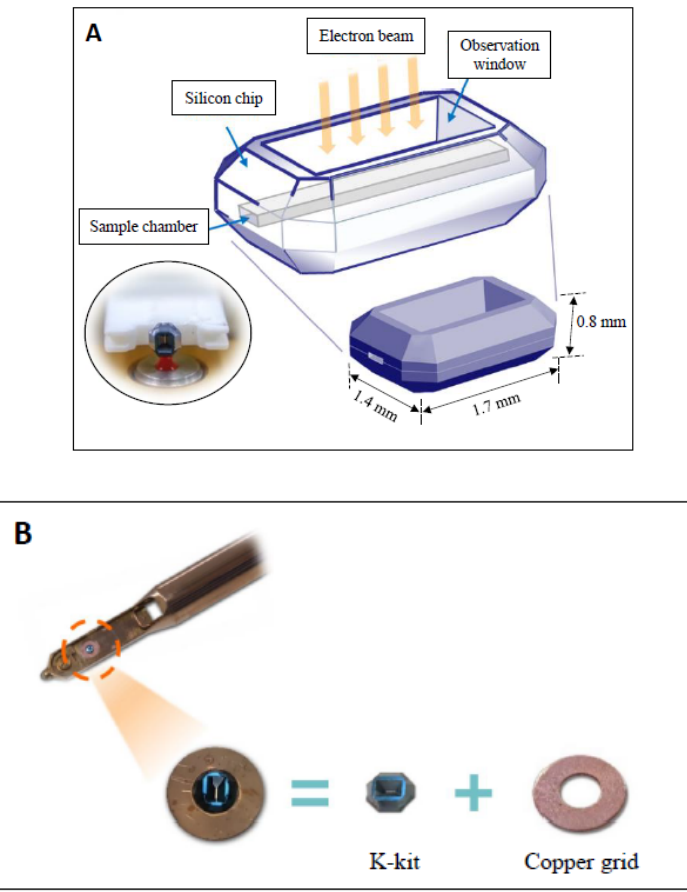
Figure 1. Schematic diagram of the K-kit microchip. ( A ) The three-dimensional structure of the K-kit microchip, which is composed of silicon metal, appeared as an octagonal cuboid-like block (1.7 mm × 1.4 mm × 0.8 mm). There are two small sample chamber openings on the left and right ends of the long axis of the microchip. The liquid specimen can naturally enter the sample chamber by touching the specimen through the openings (as shown in the ovoid circle). The upper and lower sides of the microchip are depressed to form an observation window. Only the area of the observation window allows the electron beam of electron microscope to pass through the specimen to generate a high-resolution image of the specimen. ( B ) After the K-kit microchip is loaded with the liquid specimen, the two ends of the sample chamber are sealed, and the microchip is placed and fixed in the center of a copper grid (3 mm in diameter with a 1 mm diameter hole in the center). The grid combined with the microchip can be directly placed on the grid holder of a traditional electron microscope for ultrastructural examination.